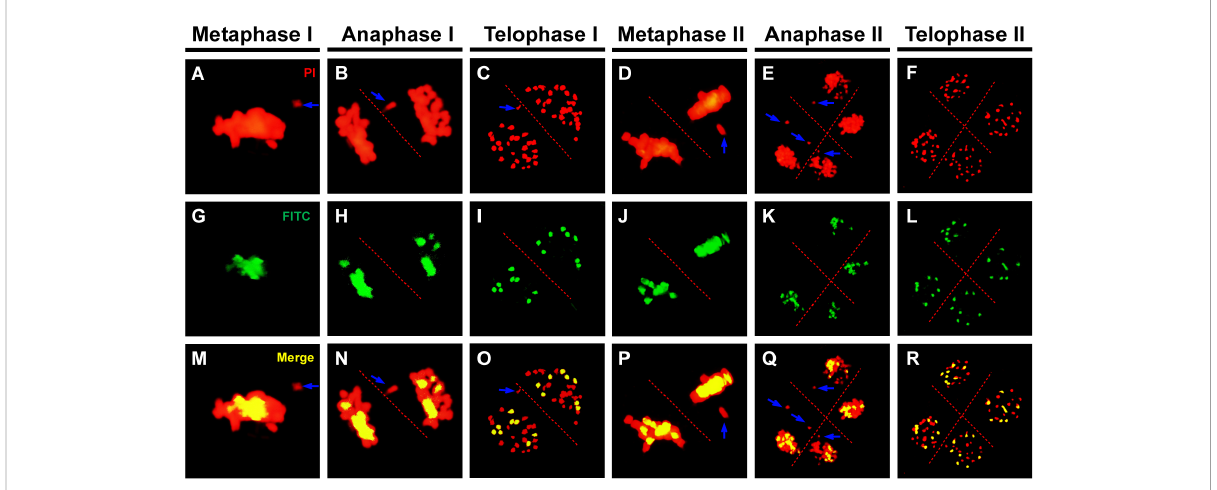
FIGURE 6 Genomic in situ hybridization (GISH) analysis of the Brassica allohexaploids during meiosis. (A – F) Chromosomes stained with propidium iodide (PI, red). (G – L) B genome chromosomes labeled by fl uorescein isothiocyanate (FITC, green). (M – R) Merged overlay of the two signals (yellow). Blue arrows indicate lagging chromosomes from the A or C genome. Bars = 10 µm.